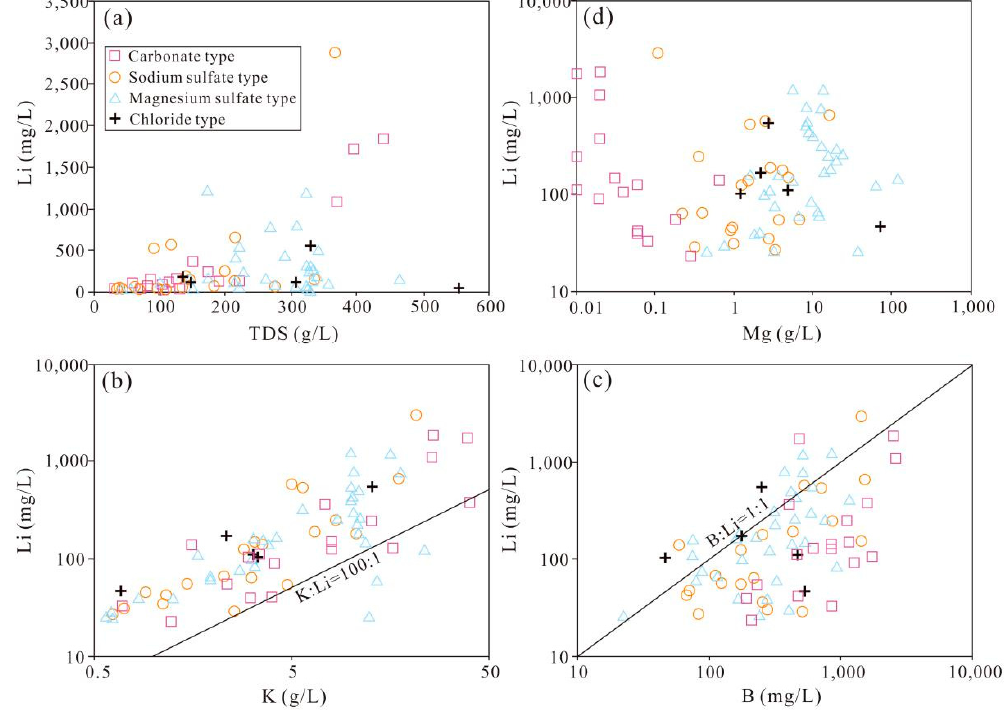
Figure 3. ( a ) Li vs. total dissolved solids (TDS) of different type brines in salt lakes; ( b ) Li vs. Mg of different type brines in salt lakes; ( c ) Li vs. K of different type brines in salt lakes; ( d ) Li vs. B of different type brines in salt lakes. The data of salt lakes on the QTP can be seen in Table 1.